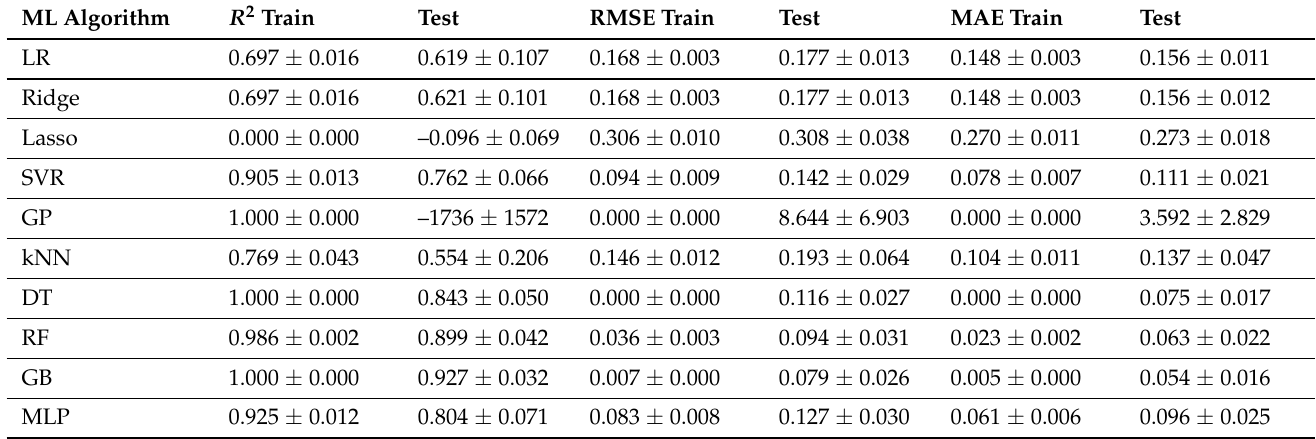
Table D1. Detailed metrics ( R 2 , RMSE and MAE) obtained for the ten screened models with default HPs.